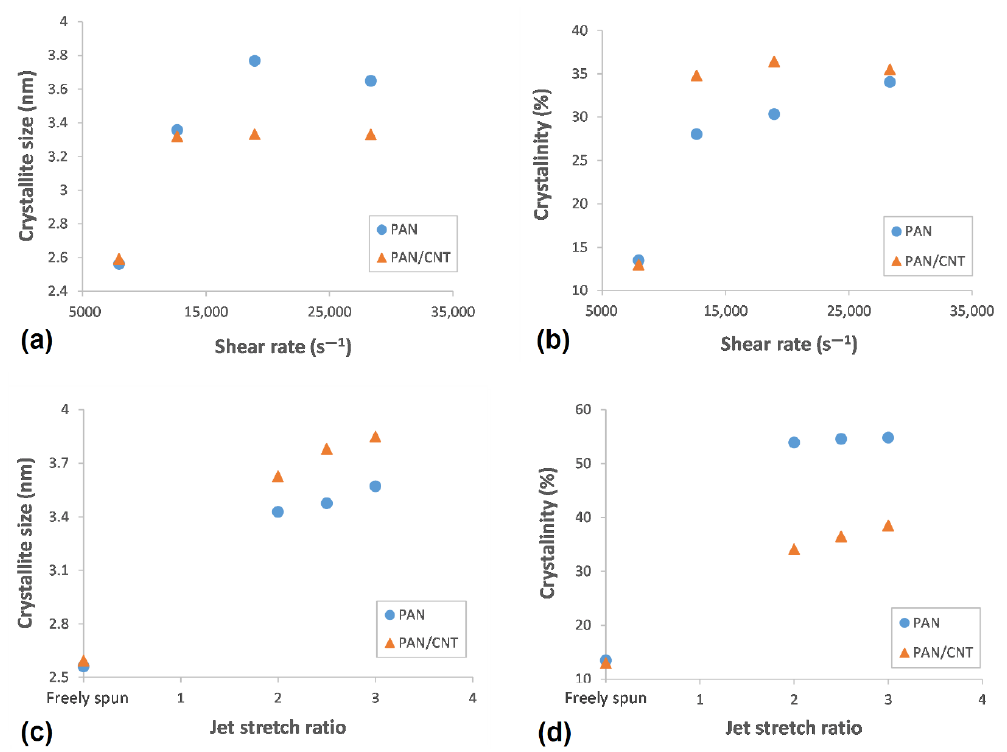
Figure 6. ( a ) The crystallite size and ( b ) crystallinity of PAN and PAN/CNT fibers as a function of shear rate, ( c ) The crystallite size and ( d ) crystallinity of PAN and PAN/CNT fibers as a function of and jet stretch ratio.